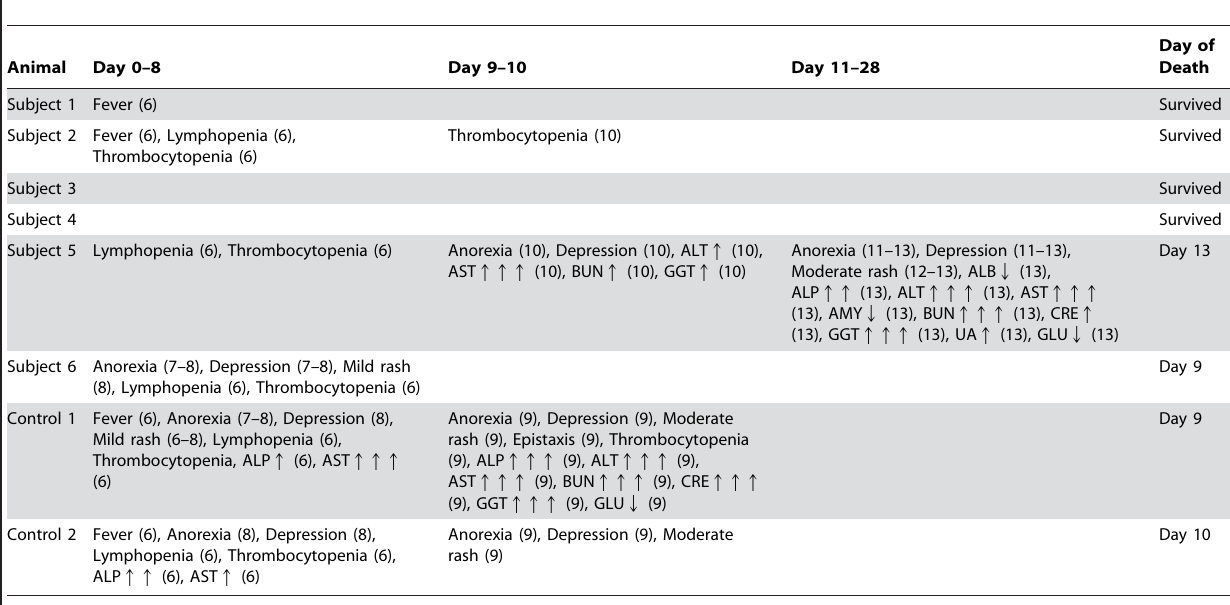
Table 3. Clinical findings in SHIV-infected rhesus monkeys challenged with ZEBOV.